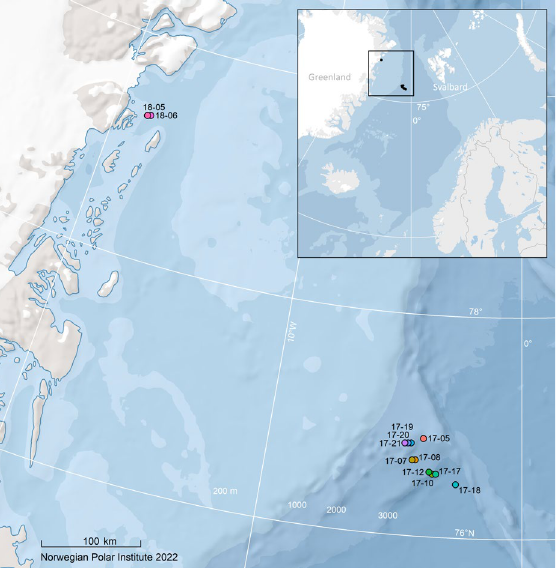
Figure 1. Sampling locations of the bowhead whale skin biopsies used in this study. The map was generated based on publicly available ArcMap polar projections documents using ArcGIS 10.1 (www. esri.